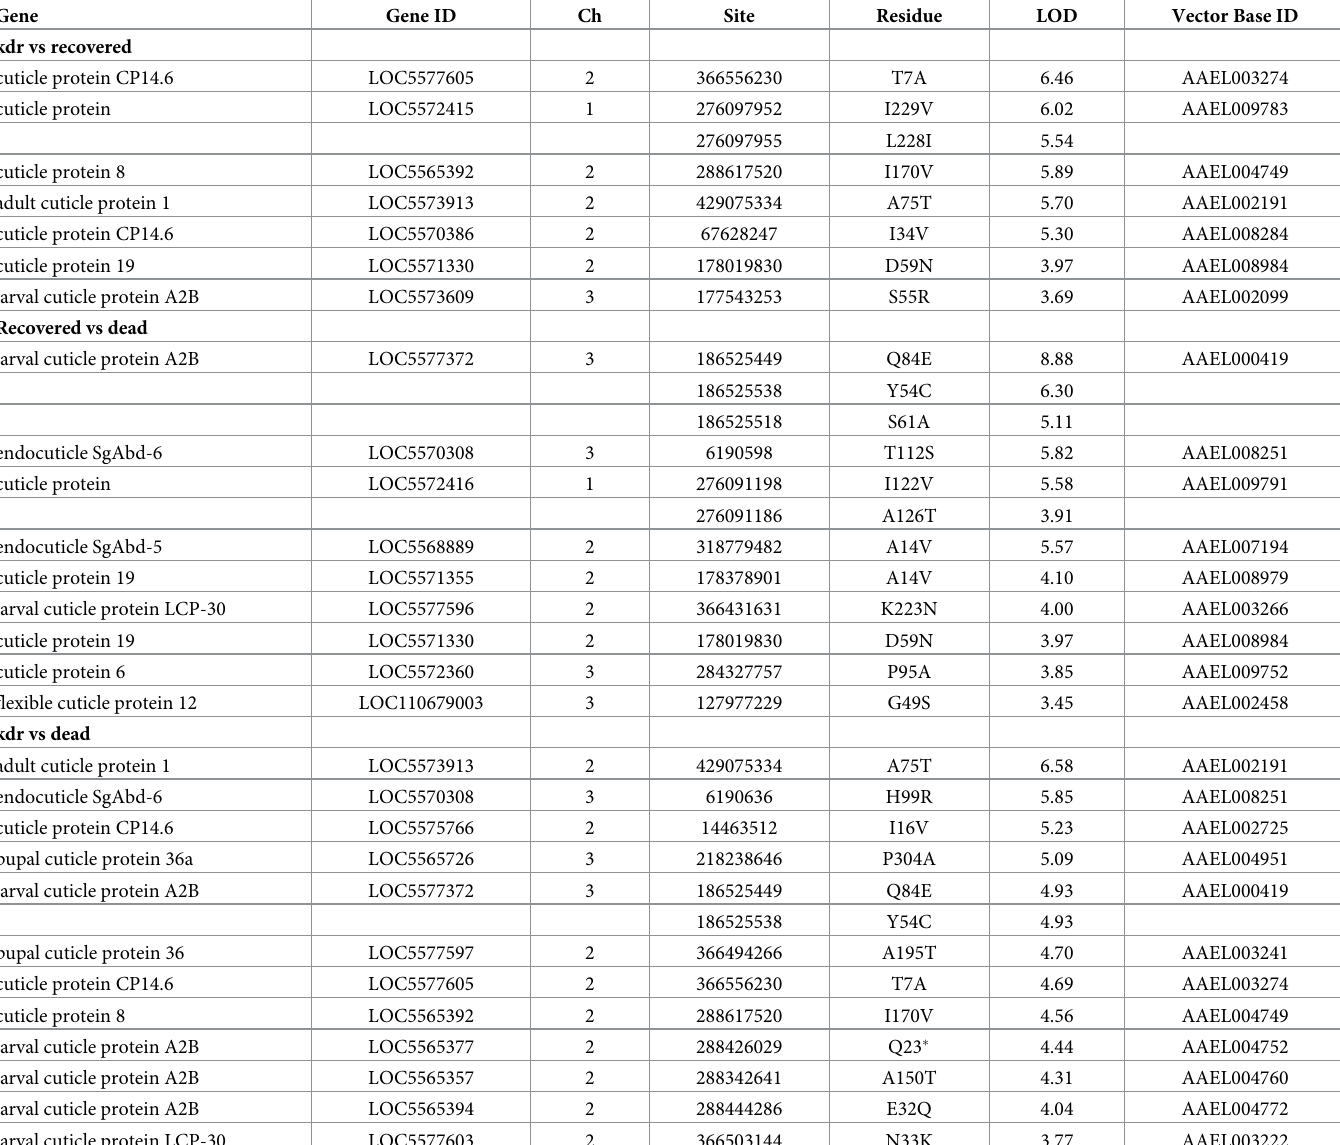
Table 3. Nonsynonymous SNPs in cuticular protein genes associated with kdr, recovered, or dead Aedes aegypti exposed to permethrin. Gene identification, chro- mosome (Ch), SNP site, amino acid residue (based in the AaegL5 genome assembly), LOD = -log 10 ( p value) and vector base identification